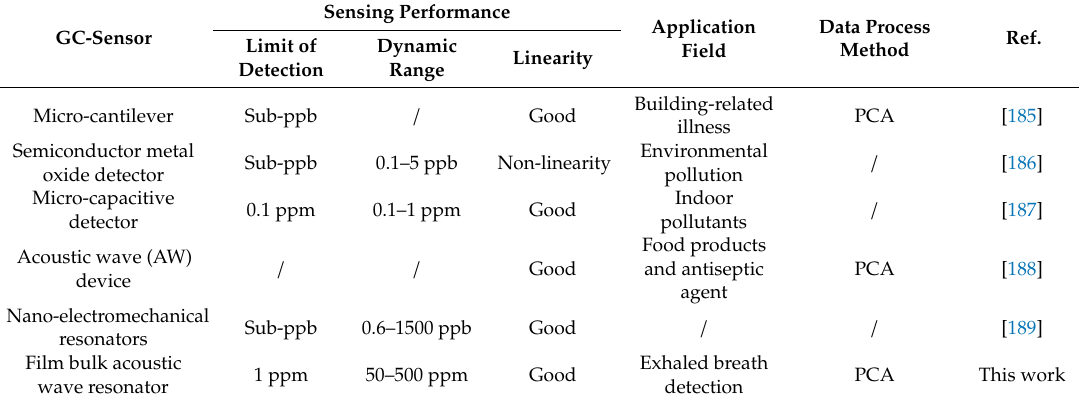
Table 5. Comparison of di ff erent GC-sensor systems with developed FBAR sensor in terms of limit of detection, dynamic range, linearity, application field and data process method, adapted with permission from